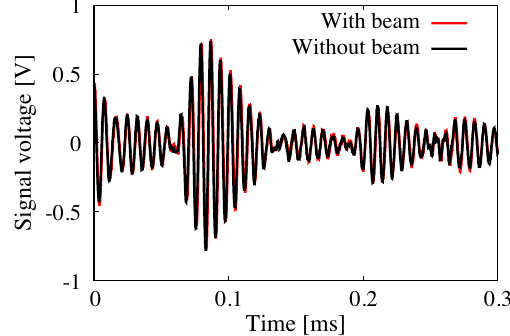
FIG. 9. Time domain signals of the CT with a waste beam (red line) and with no beam (black line). The signals are almost identical, and it is extremely difficult to get a real beam